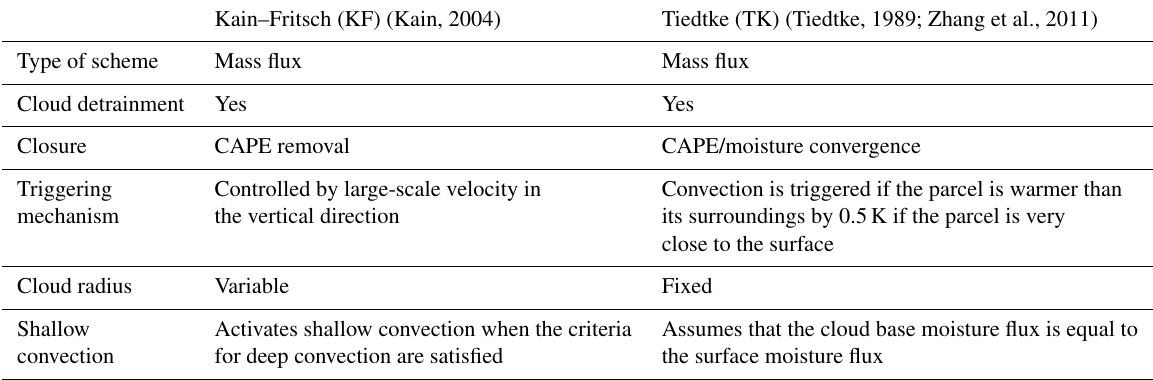
Table 1. Description of the cumulus schemes used in this study. Kain–Fritsch (KF) (Kain, 2004) Tiedtke (TK) (Tiedtke, 1989; Zhang et al., 2011)